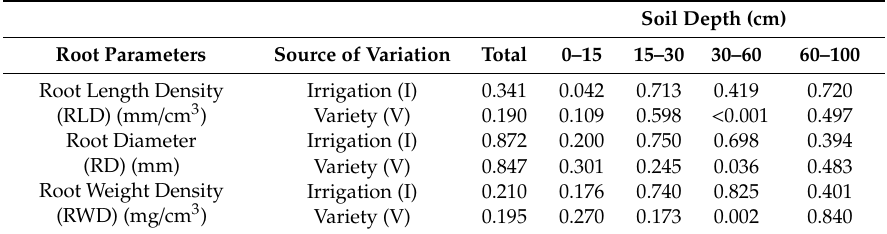
Table 4. Analysis of variance p -values indicating di ff erences or not between irrigation and variety for root length density, root diameter, and root weight density at di ff erent soil depths in 2015 at Alton